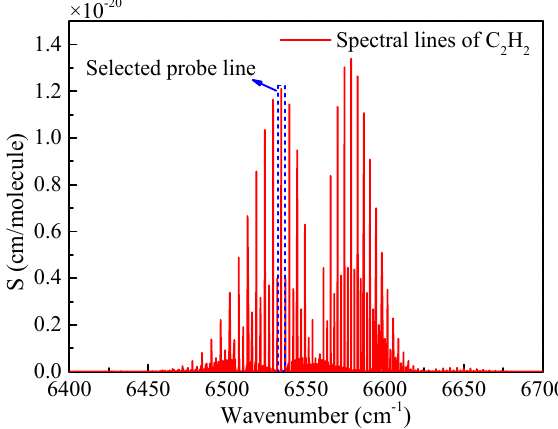
Figure 1. Spectral lines of acetylene (C 2 H 2 ) for a spectral range from 6400 cm -1 to 6700 cm -1